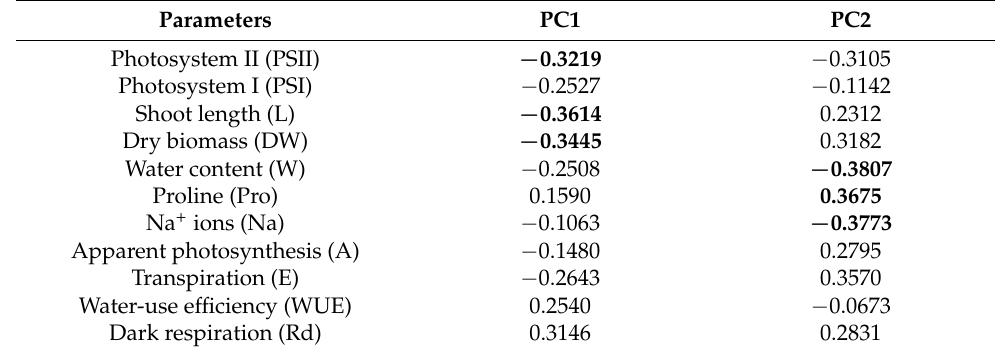
Figure 4. Principle component analysis (PCA) ( a ) score plot of the physiological data of C 4 Kochia prostrata at different CO 2 concentrations (400 and 800 ppm) under moderate (–0.6 MPa) PEG-induced osmotic stress and salinity similar in osmotic po- tential (200 mM NaCl) and ( b ) multiple correlation of the physiological data of C 4 Kochia prostrata . aCO 2 —ambient (400 ppm) CO 2 concentration without treatment; aCO 2 + Osm—ambient CO 2 + PEG-induced osmotic stress; aCO 2 + Salt—ambient CO 2 + NaCl-induced salinity; eCO 2 —elevated (800 ppm) CO 2 concentration; eCO 2 + Osm—elevated CO 2 + PEG-induced osmotic stress; eCO 2 + Salt—elevated CO 2 + NaCl-induced salinity. Parameters abbreviations are listed in table. Table 1. Factor loading of physiological parameters on axes 1 and 2 of the principal component